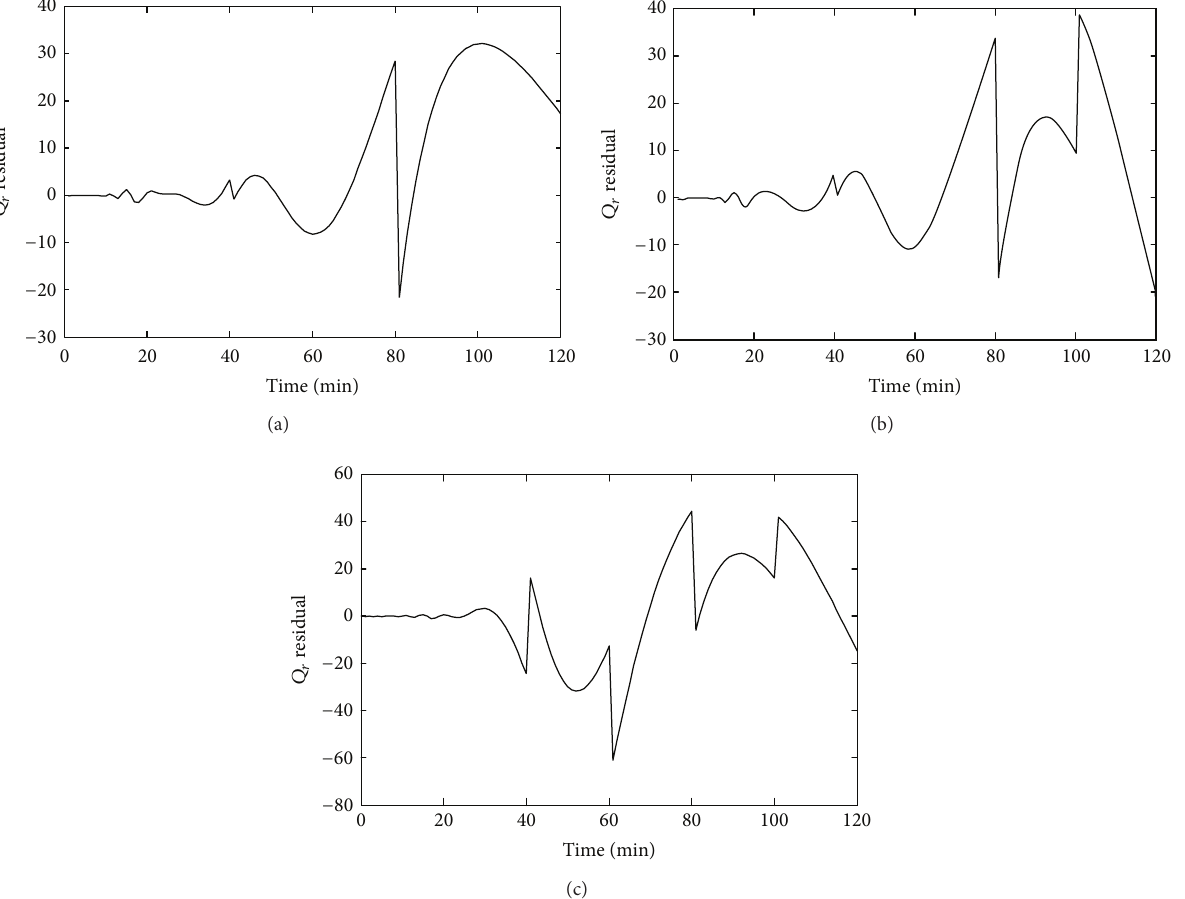
Figure 12: Residual (in terms of 𝑄 𝑟 ) due to actuator freezing at different time intervals. (a) Residual (in terms of 𝑄 𝑟 ) due to actuator freezing at the time interval (40–120 min). (b) Residual (in terms of 𝑄 𝑟 ) due to actuator freezing at the time interval (80–100 min). (c) Residual (in terms of 𝑄 𝑟 ) due to actuator freezing at the time interval (40–60min).